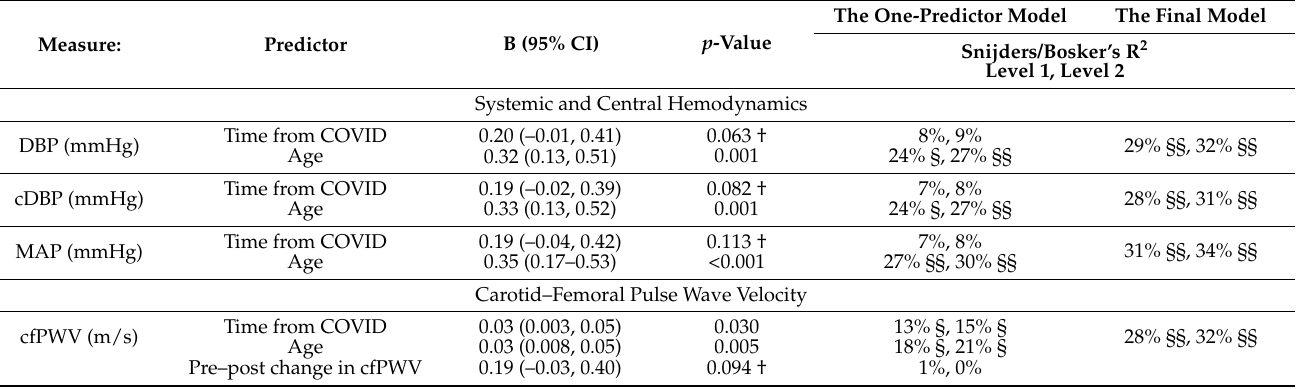
Table 4. Predictors of values of systemic and central hemodynamic parameters, as well as arterial stiffness parameters, estimated by the mixed methods regression